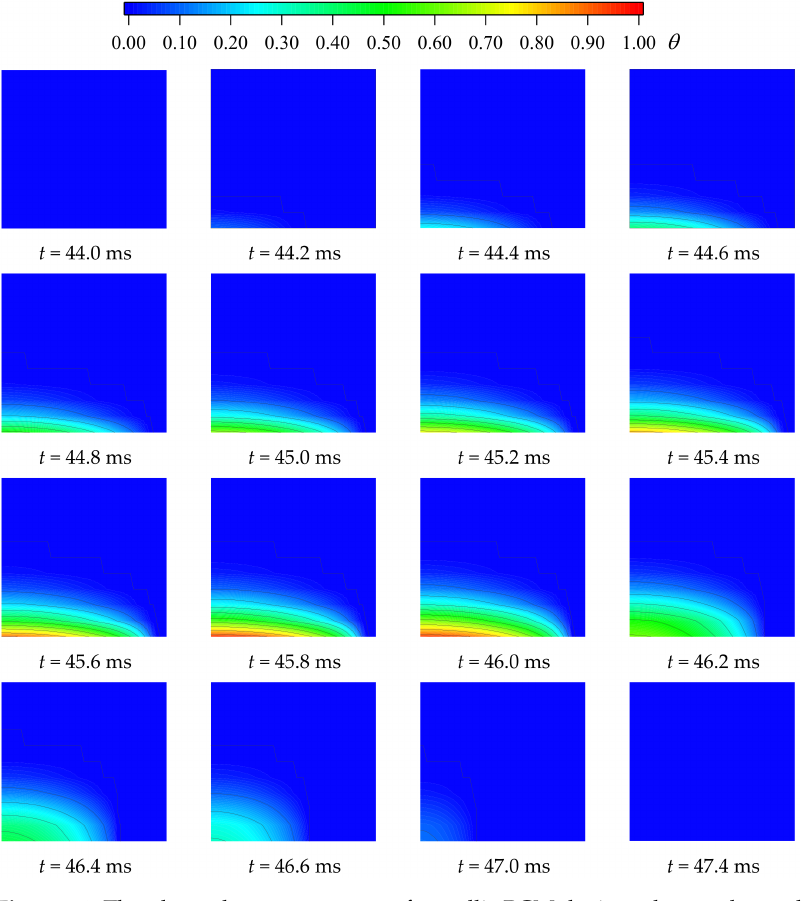
Figure 14. The phase change processes of metallic PCM during a heat pulse cycle under low peak heat flux and large duty cycle pulses